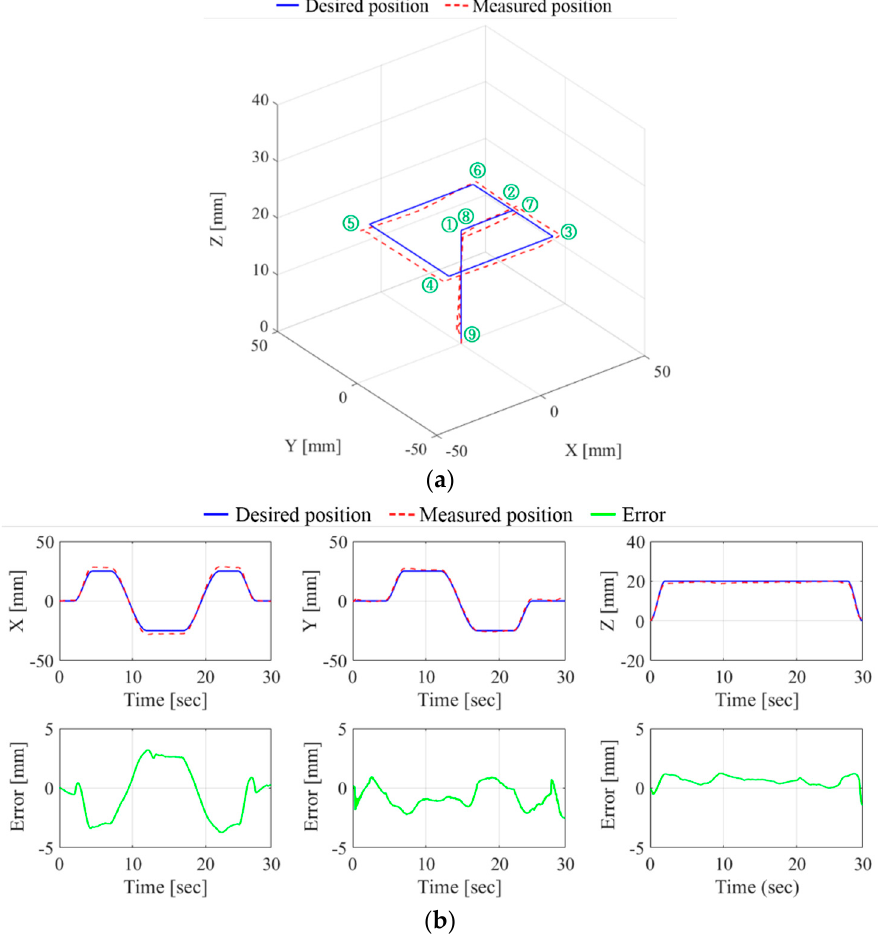
Figure 8. Comparison of the desired position and measured position in ( a ) 3D space and ( b ) 1D space. Table 3. Measured error of the EE on the trajectory.